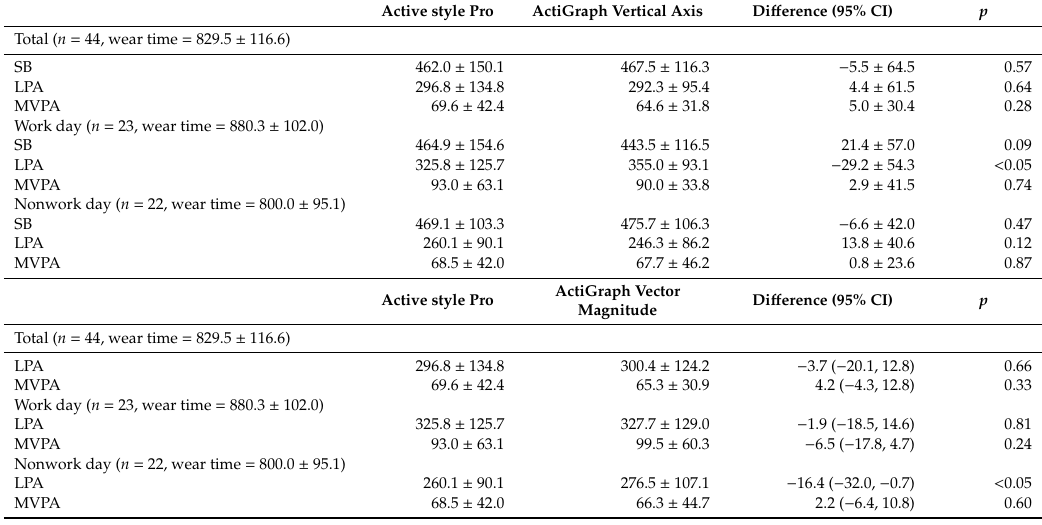
Table 3. The di ff erences of PA outputs between Active style Pro and ActiGraph using the correction factors.